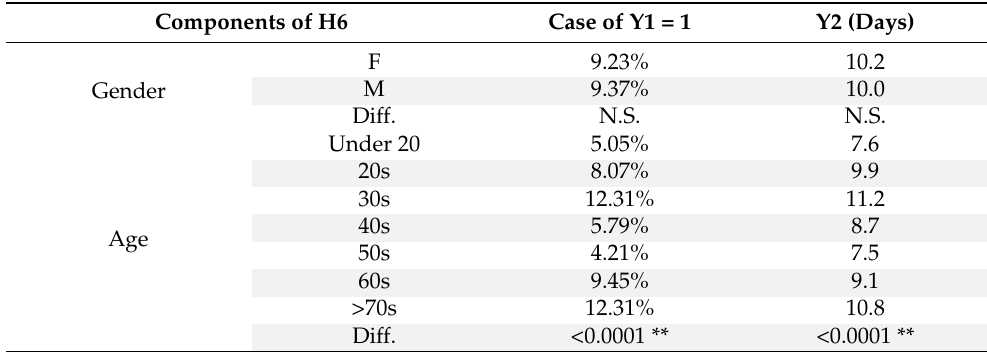
Table 5. Result of analysis